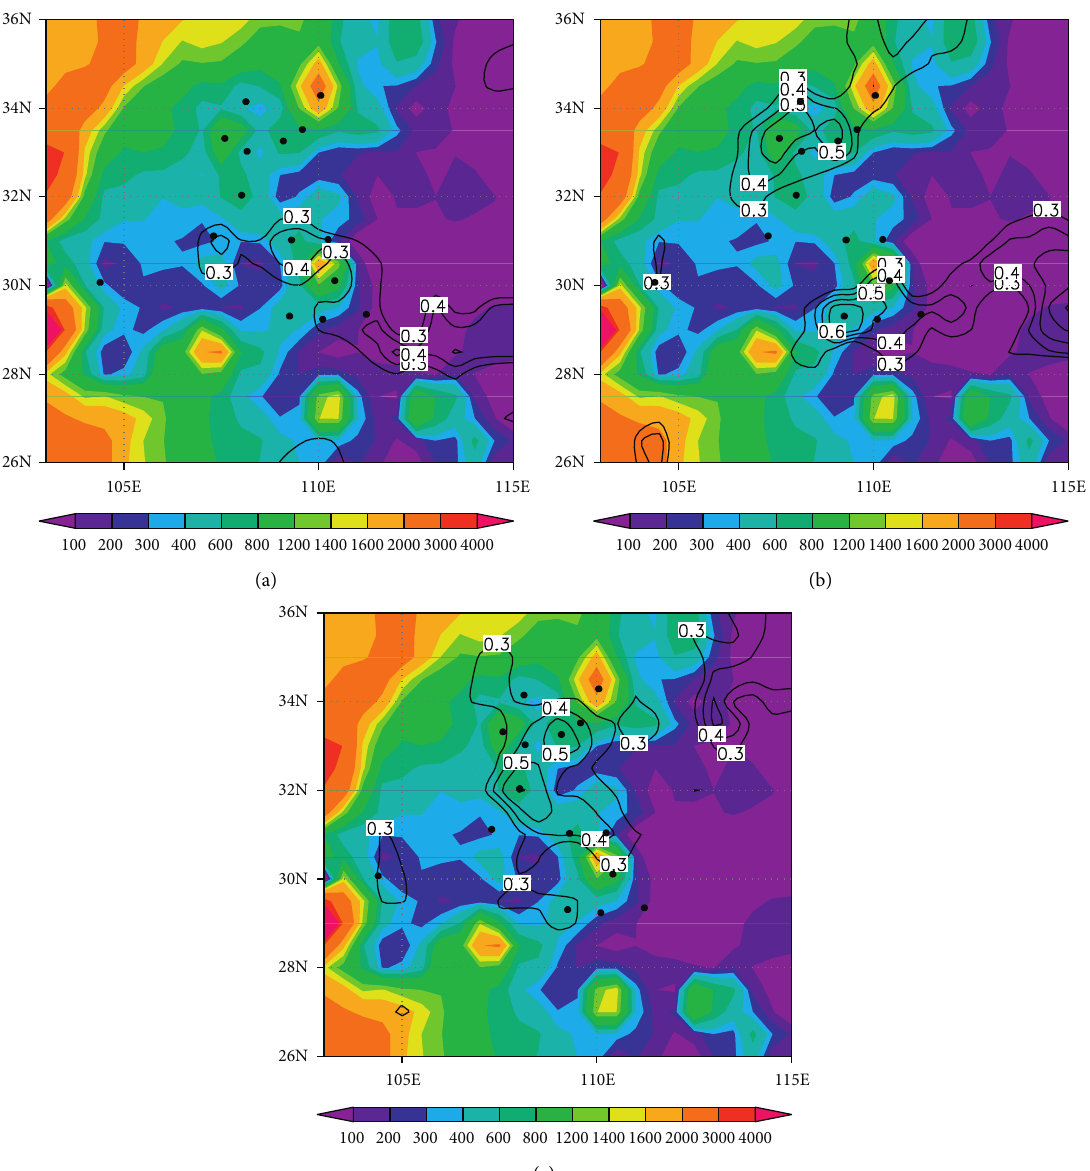
Figure 2: Distribution of correlation coefficients between monthly precipitation and prewinter Niño3 SST index from 1979 to 2008: June (a); July (b); August (c). The contour lines denote the correlation coefficients above the 95% confidence level. The shaded area denotes the altitude (units: m). The black dots denote the stations in the western mountainous region with the correlation coefficients between the JJA precipitation and the prewinter Niño3 SST above 95% confidence